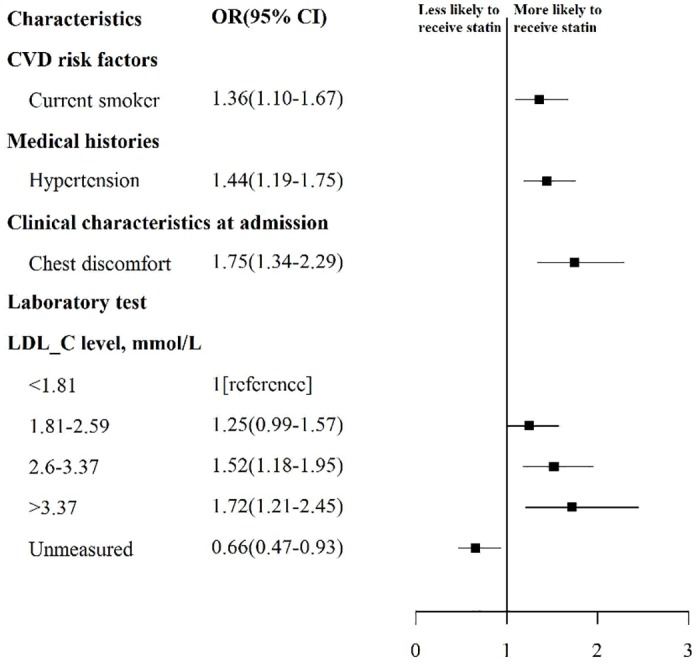
Factors Independently Associated with Statin Use in 2011.Variables with significant association with any usage of statin are shown along the vertical axis. The strength of effect is shown along the horizontal axis with the vertical dotted line demarking an odds ratio of 1 (that is, no association); estimates to the right (that is, > 1) are associated with greater likelihood of early statin use, while those to the left (that is, < 1) indicate association with reduced likelihood of early statin use. Each square and line represents the point estimate of the effect of that variable in the model, while the line shows the 95% confidence interval. CVD indicates cardiovascular disease.